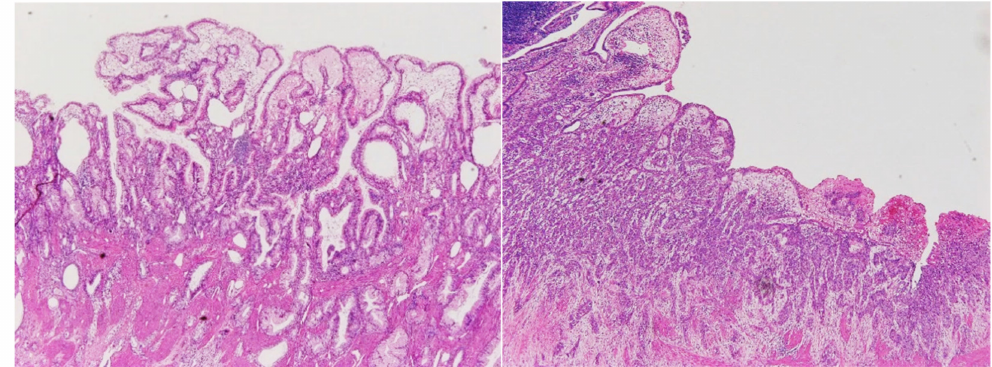
Figure 2. Histological images (hematoxylin and eosin stain, 4 × objective lens) of tubular adenocarcinomas representing the moderately-differentiated type (left) and the poorly-differentiated type